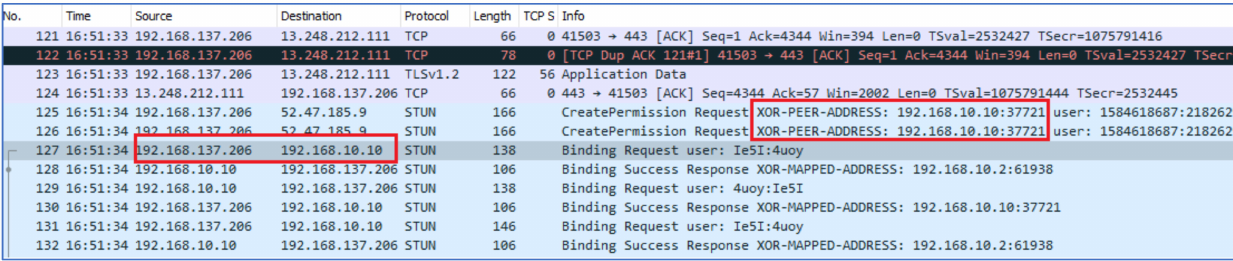
Figure 10. Receiver’s IP address during call initiated by User